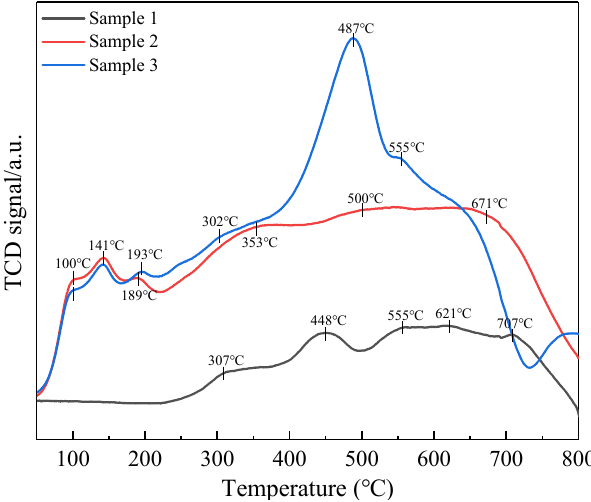
Figure 5. NH 3 -TPD of the catalyst before and after modification.